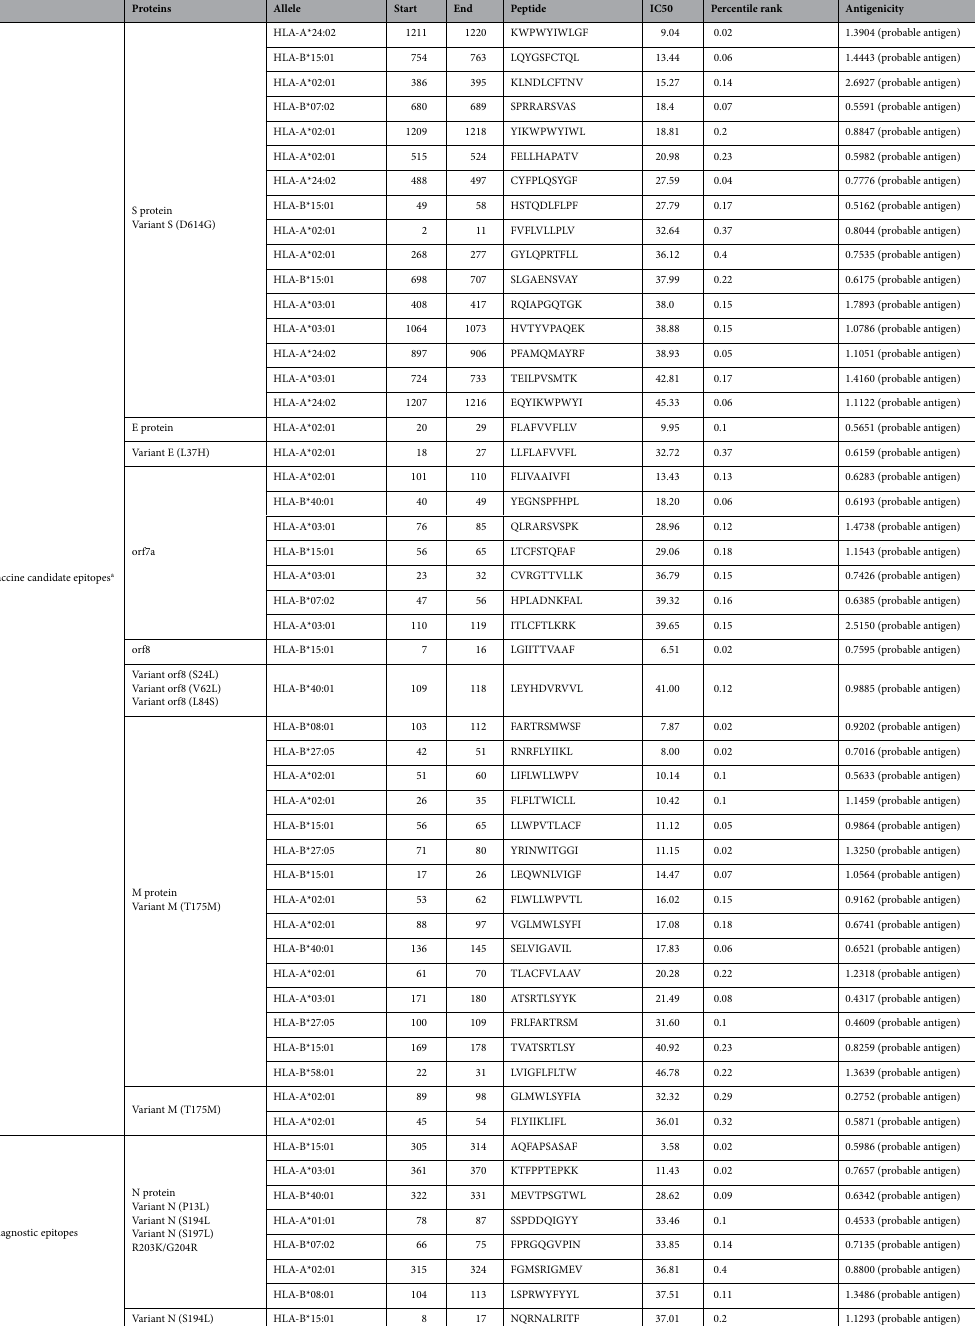
Table 7. Epitopes specific to selected MHC-I alleles. a Vaccine candidate epitopes can also be used to develop serodiagnostic